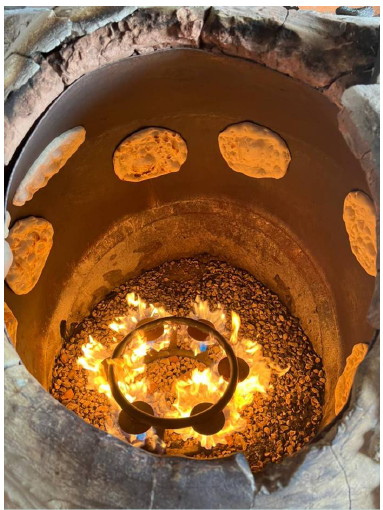
Figure 8. Dough discs pressed onto the inner walls of tannur for baking.